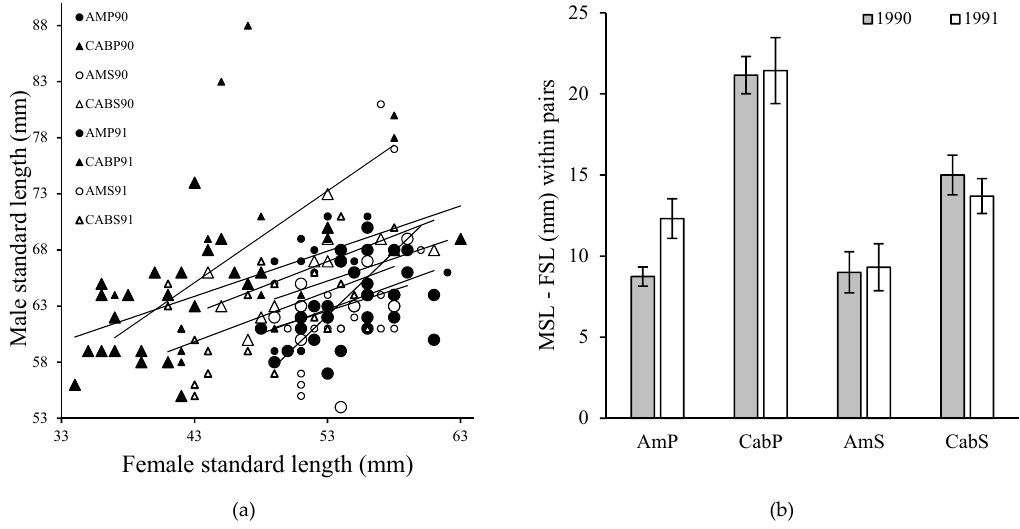
Figure 2. The number of breeding pairs actively guarding broods in the dry seasons of 1990 and 1991 within defined study areas in the Río Cabuyo and its tributary Quebrada Amores, located in and adjacent to Lomas Barbudal Biological Reserve, Guanacaste, Costa Rica. Data from [9]. Convict cichlids form monogamous pair bonds and jointly defend a nest cavity from competing conspecific reproductive pairs. Within pairs, males are larger than females and this species shows size-assortative mating (Figure 3). Biparental care is uncommon in fishes. For convict cichlids in this study system, biparental care is more effective than uniparental care in defending against brood predators [9], and allows pairs to defend two territories simultaneously: the mobile territory surrounding the brood, and the fixed territory around the spawning lair. Brooding adults and their offspring return to the lair each night, presumably to take refuge from nocturnal predators such as catfish Rhamdia guatemalensis . During the day, broods roam about the stream bottom foraging on the substrate. About once every 10 min, one parent, usually the male, leaves their partner and young to return to the lair to chase away conspecifics that may be looking to establish themselves there.